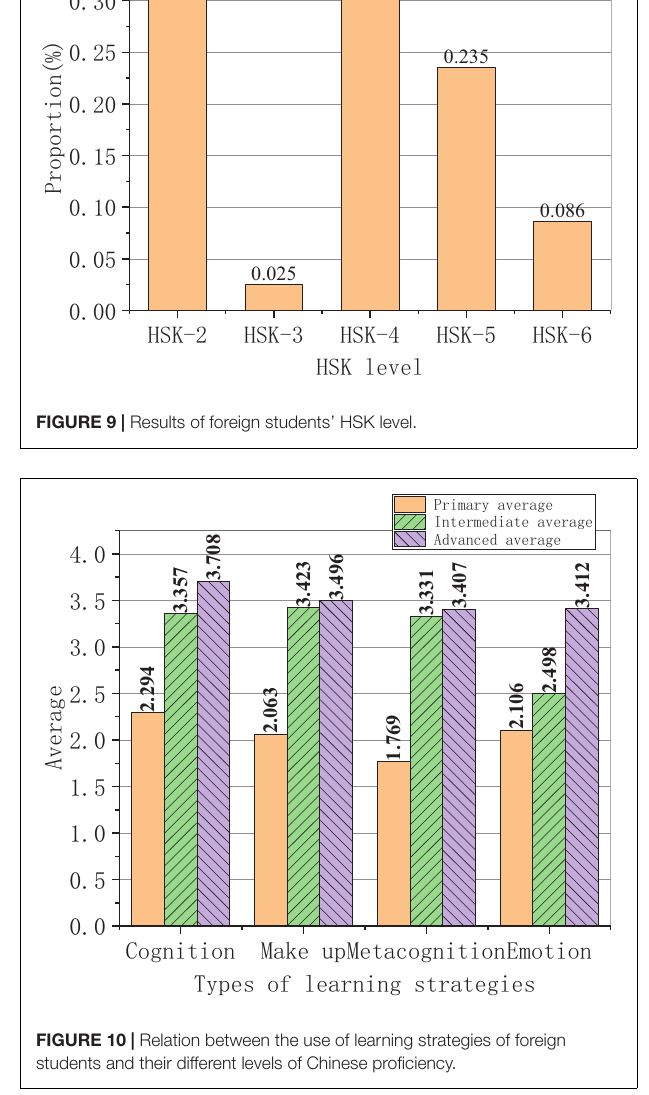
degrees for analysis: HSK-2 and HSK-3 are primary levels, HSK- 4 is the middle level, and HSK-5 and HSK-6 are high levels.